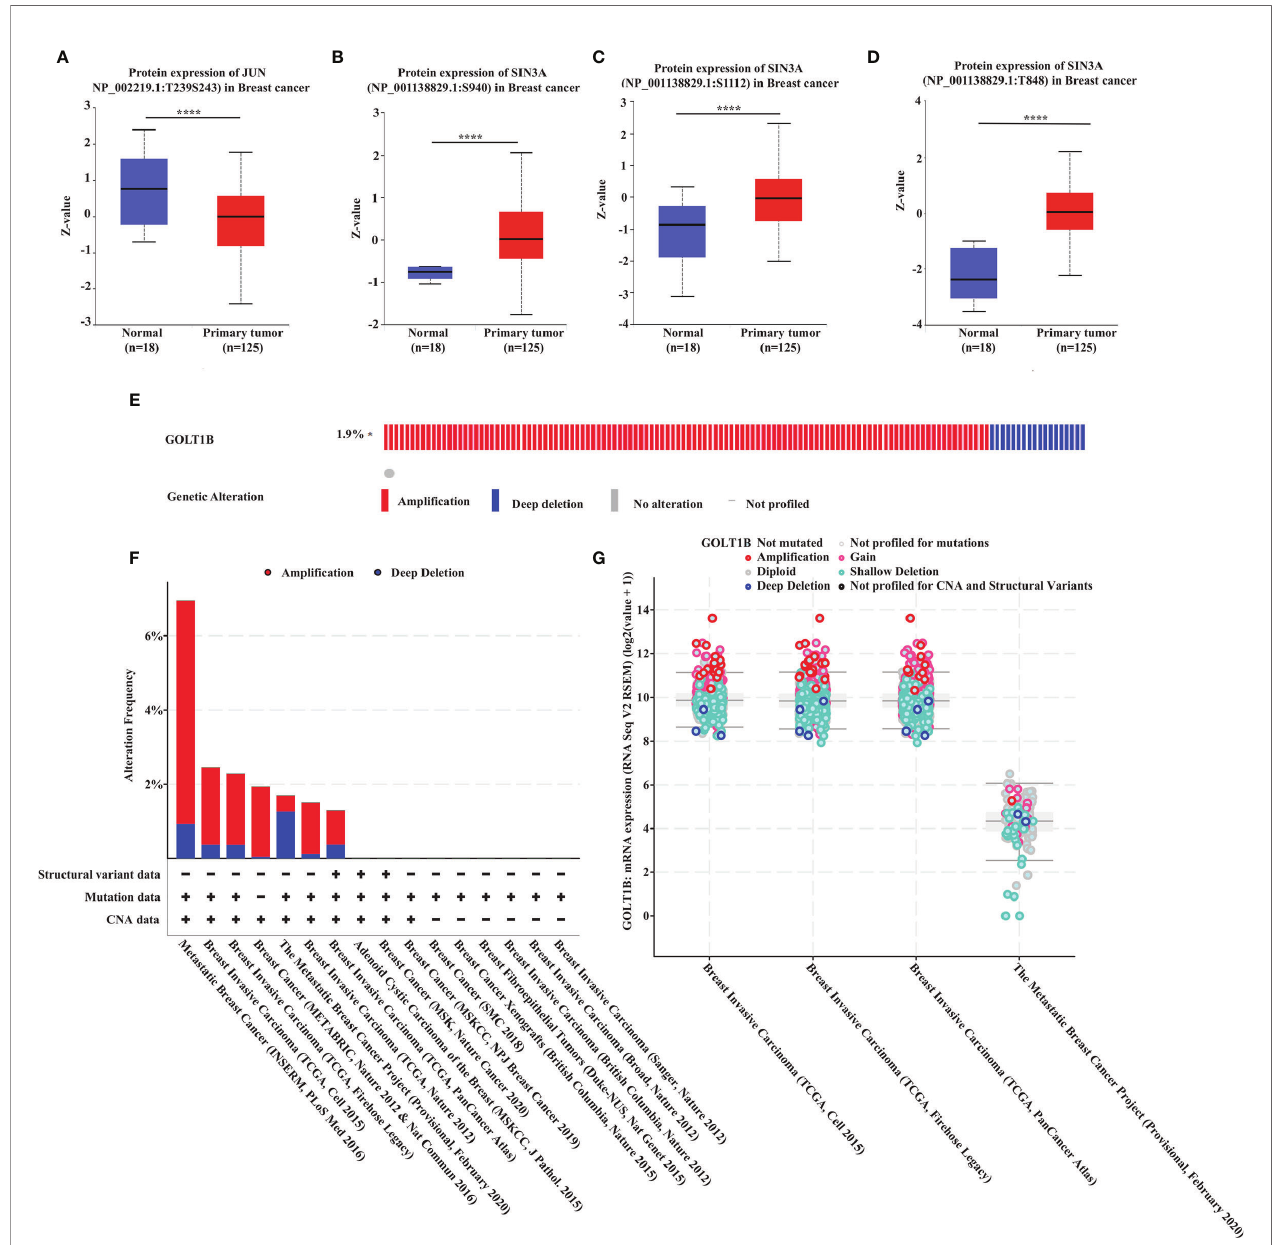
FIGURE 4 | The potential mechanism underlying the up-regulation of GOLT1B in breast cancer patients. (A – D) The phosphorylation of JUN and SIN3A in breast cancer tissues versus normal tissues. (E) The frequency of GOLT1B mutations in breast cancer patients. (F) The mutation type and frequency of GOLT1B in distinct independent studies of breast cancer. (G) The GOLT1B expression in breast cancer patients with different GOLT1B mutations. ****p <